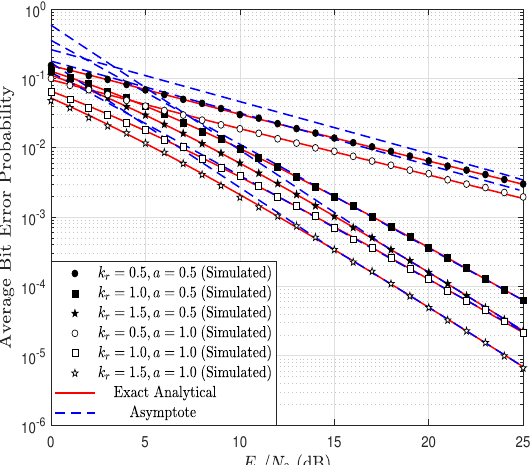
Figure 9. ABEP as a function of E s / N 0 , parameterized by k r and a considering N r = 3, N d = 4, k d = 0.9, λ r = 1.4, and λ d =